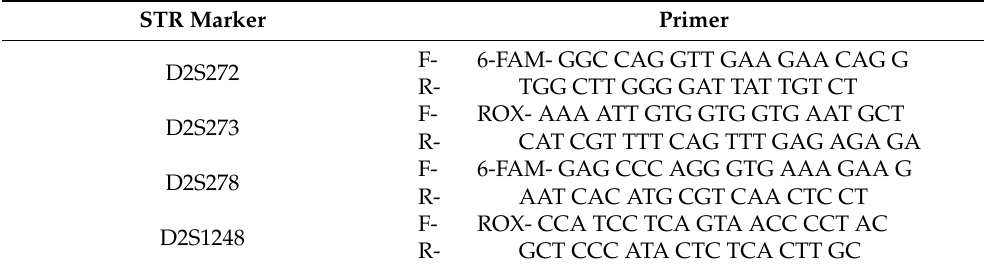
Table 1. Primers used for multiplex QF-PCR testing of STR markers located in chromosome 2. STR Marker